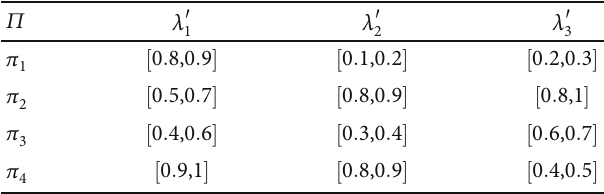
Table 5: The comparison table of Table 2.